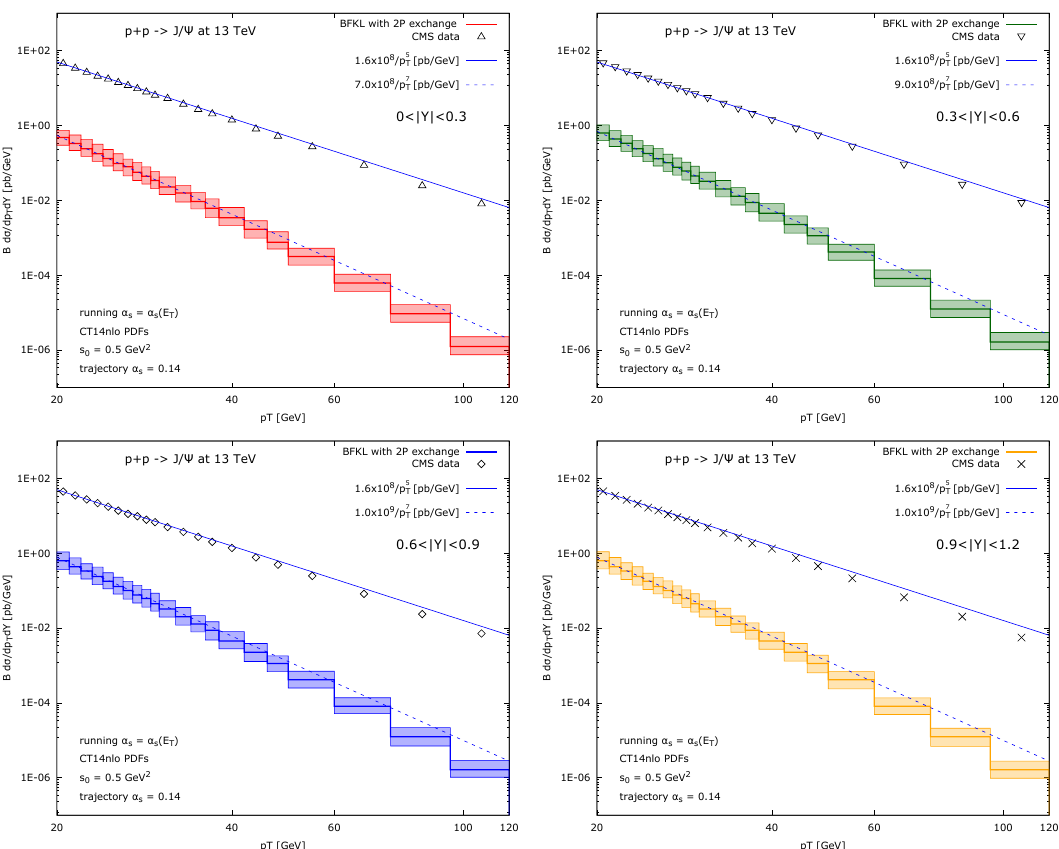
Figure 11 . The double differential cross section dσ/dp T dY for the hadroproduction of the J/ψ , times the branching ratio for leptons B . Here Y is the rapidity of the J/ψ . The solid histograms represent the double-Pomeron contribution to the cross section calculated in this work. The error estimate (shaded boxes) comes from the scale variation. We also show the power-law behaviour and C 2 /p 7 C 1 /p 5 T T